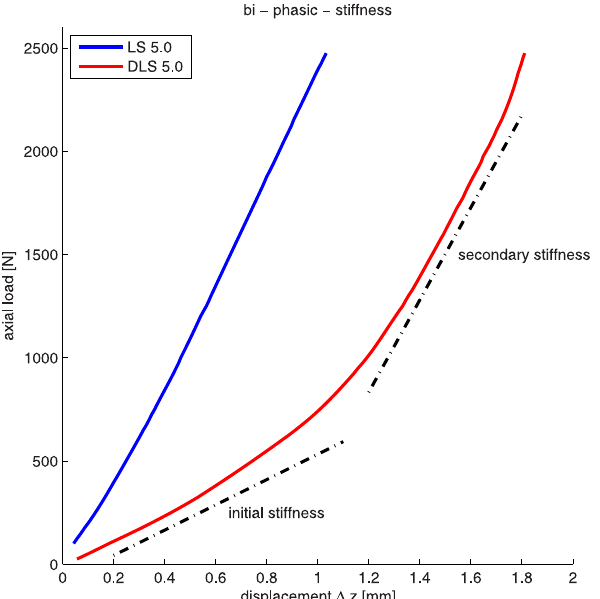
Figure 6. In comparison to the LS, the DLS showed a biphasic stiffness distribution with an initial and a secondary stiffness. The initial axial stiffness of DLS was 612.4 N/mm and secondary stiffness was 2301.9 N/mm. The mean LS axial stiffness was 2394.9 N/mm.